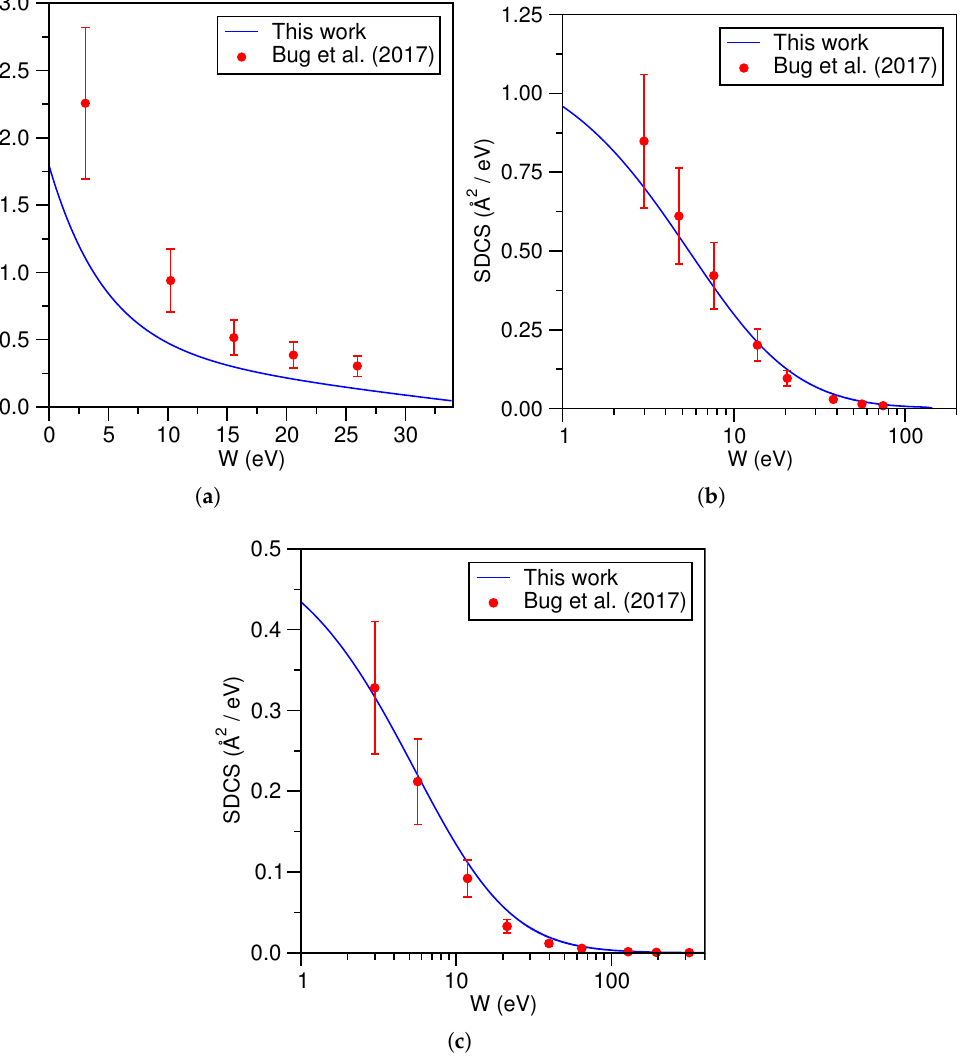
Figure 12. Electron-impact SDCS for TMP at a primary electron energy of ( a ) T = 80 eV, ( b ) T = 300 eV, and ( c ) T = 1000 eV. The solid lines are the present results, and the filled circles are the experimental points derived by Bug et al.